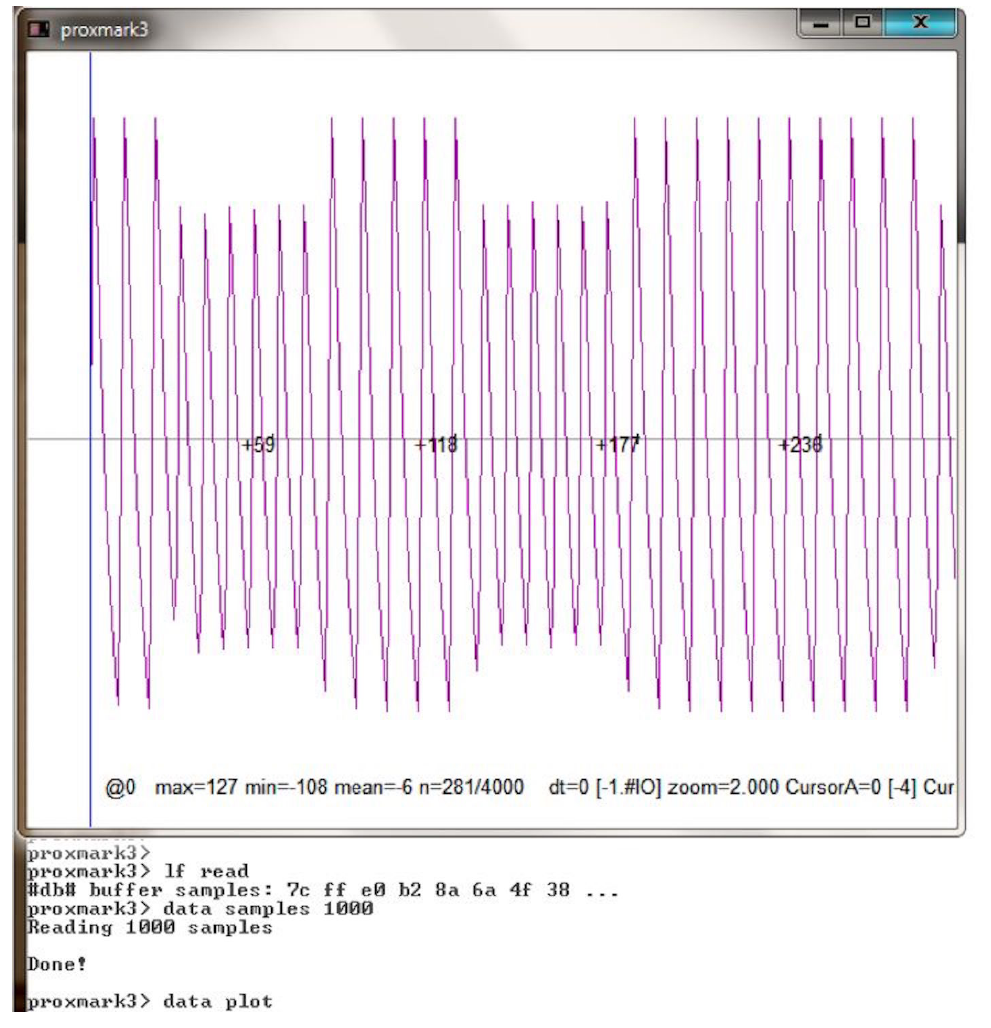
Figure 7. Example of an LF tag signal received.